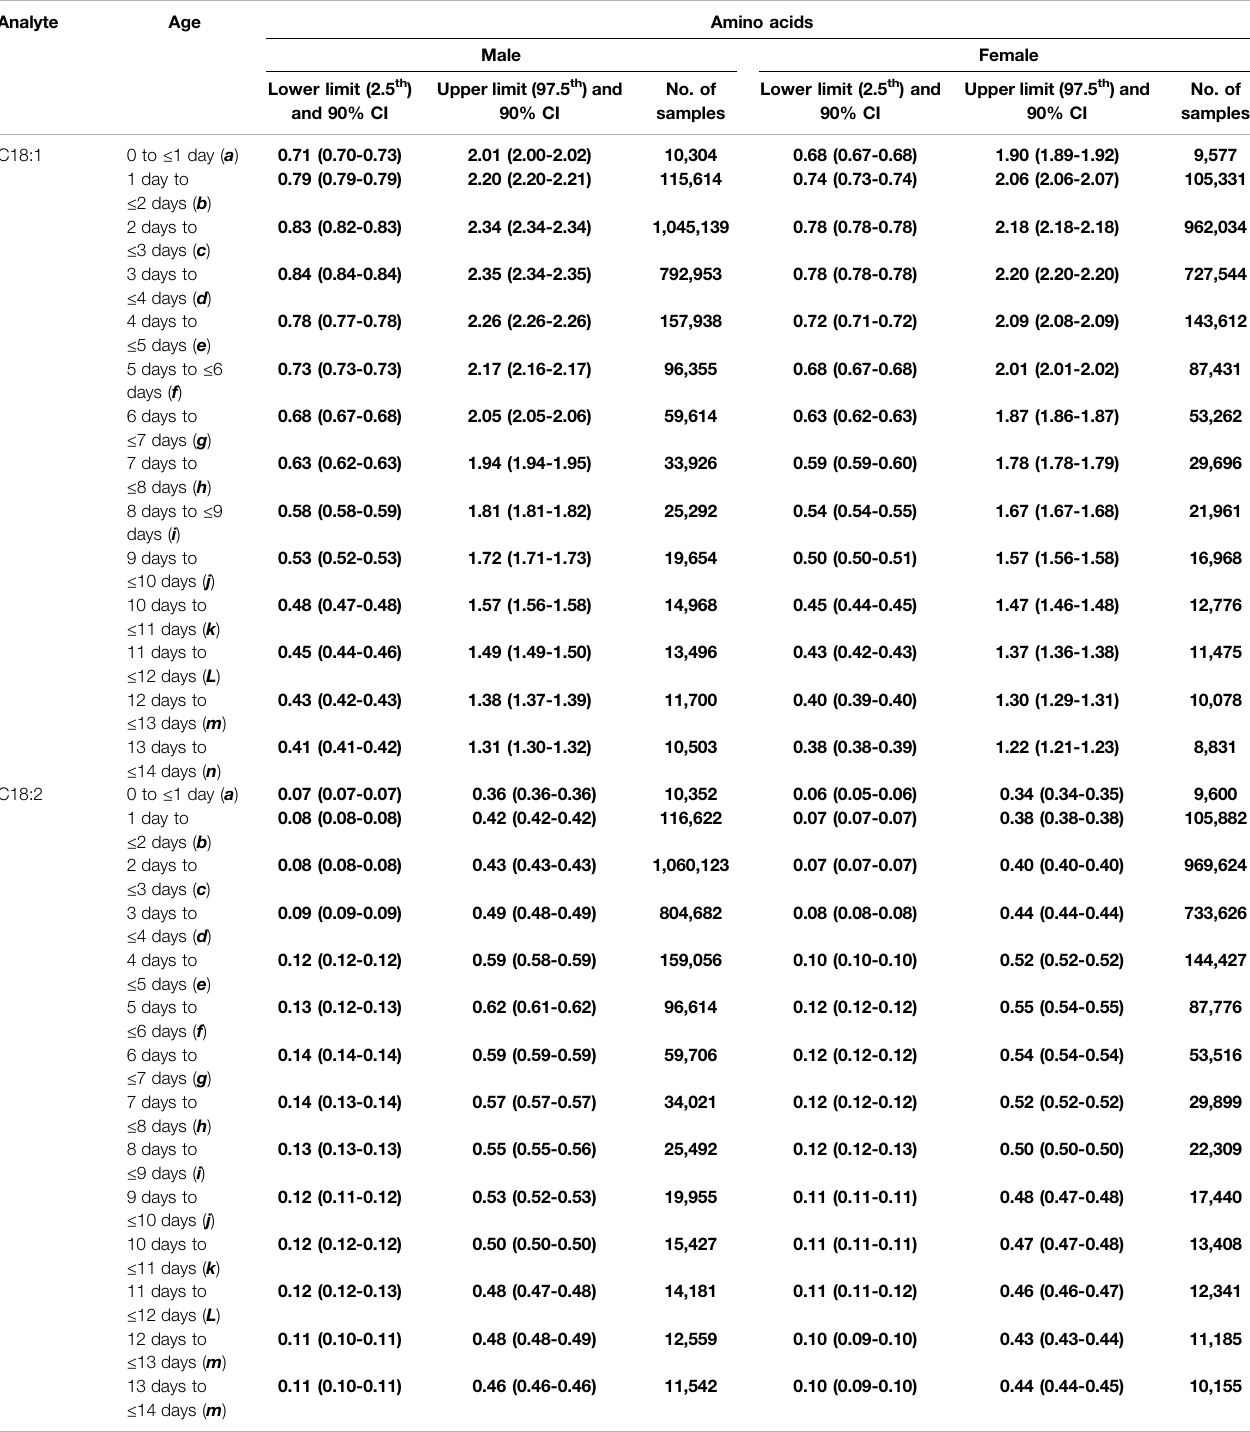
TABLE 2 | ( Continued ) The Reference intervals partitioned by each day and sex for 35 MS/MS NBS biomarkers ( μ